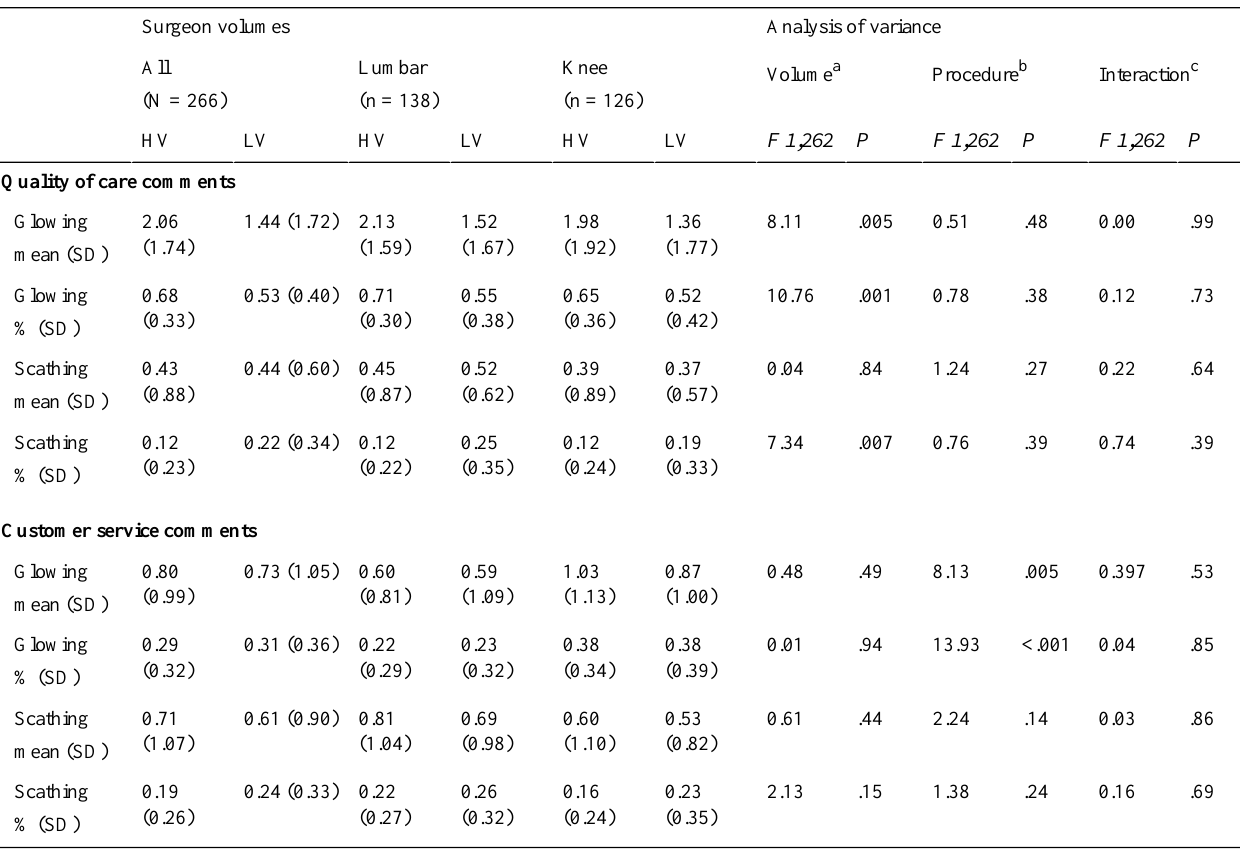
Table 9. Analysis of scathing and glowing comments for high- and low-volume surgeons on first 20 websites (excluding bariatric surgeons).